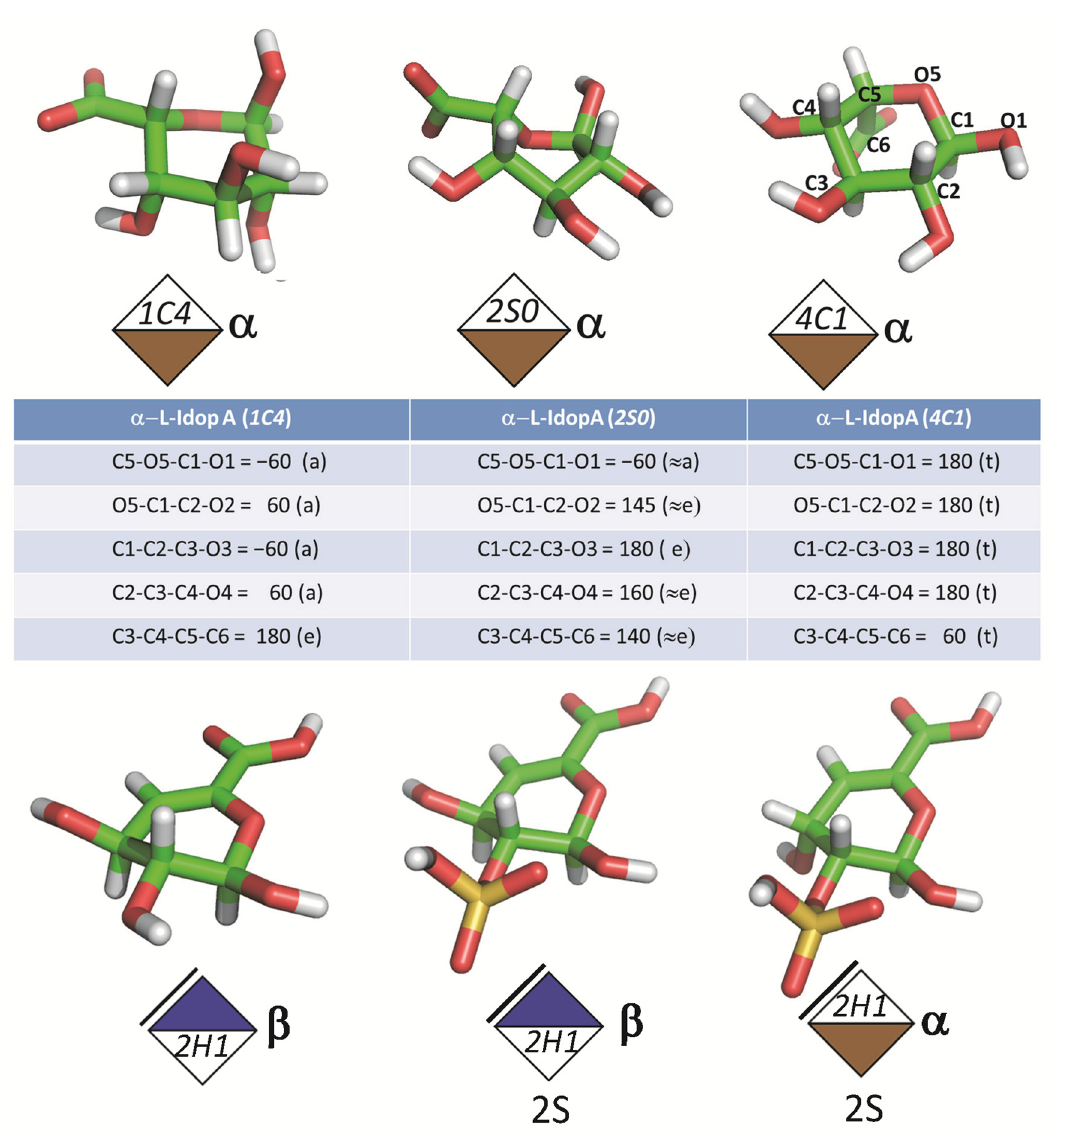
Figure 6. 3-D structures, descriptors, and schematic representations of L-Idopyranosides, the following 1 C 4 C 2 S 4 , 1 , and 0 ; and 4,5 unsaturated uronic acids (drawn with pyMol